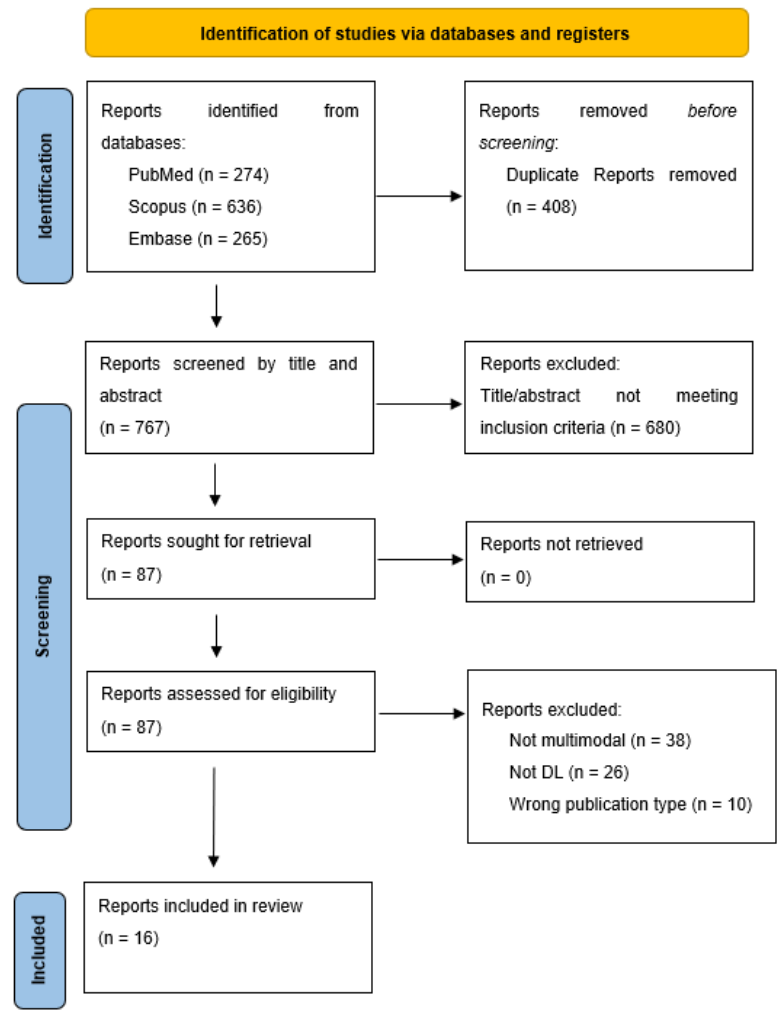
Figure 1. PRISMA Flowchart.